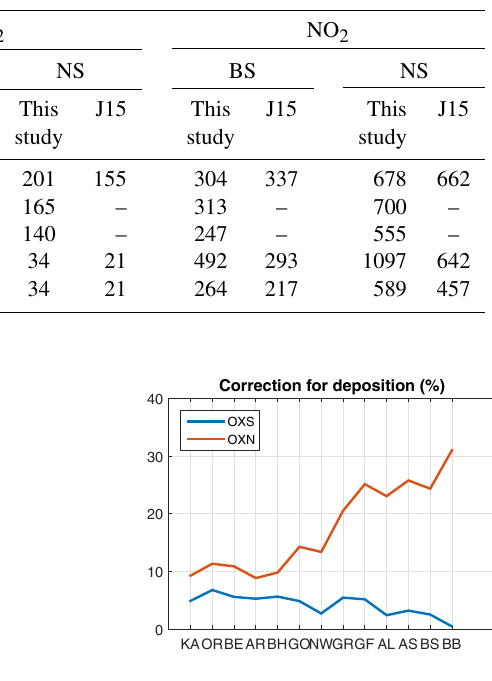
Figure 12. Correction of deposition caused by ship traffic in the different Baltic Sea